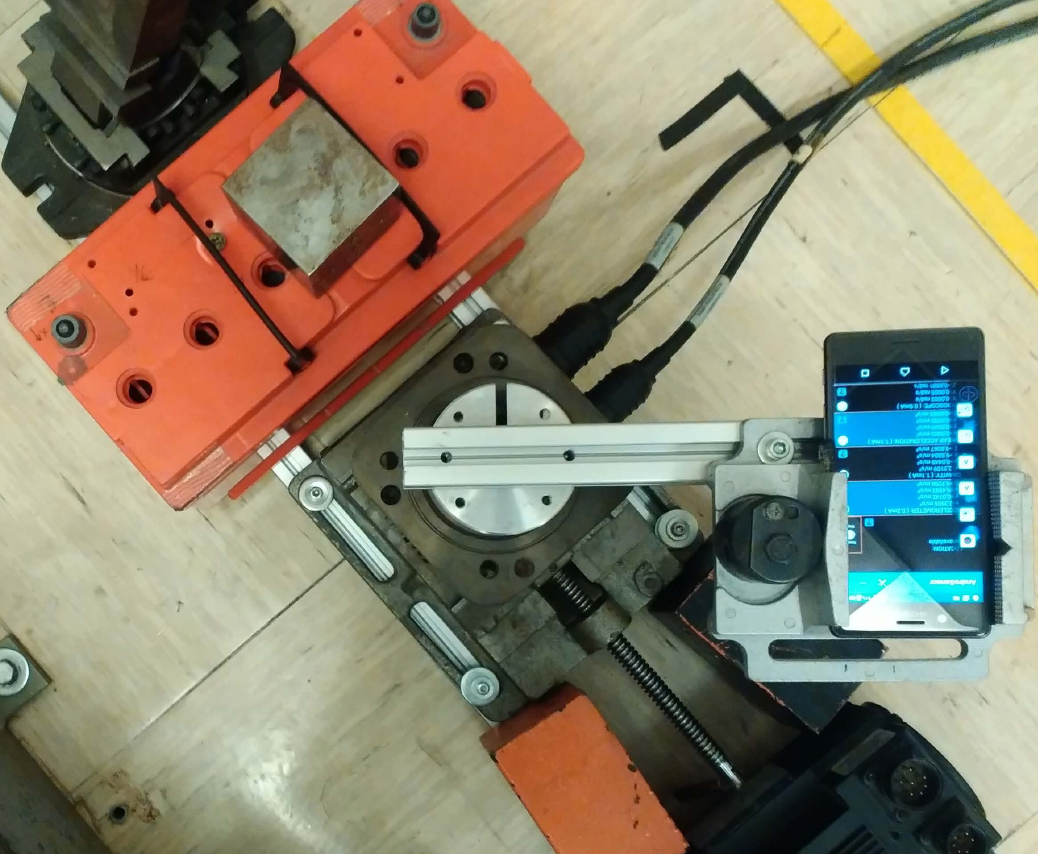
Figure 2. Image of the test setup used to collect the data. Table 1. List of mobile phones used in our